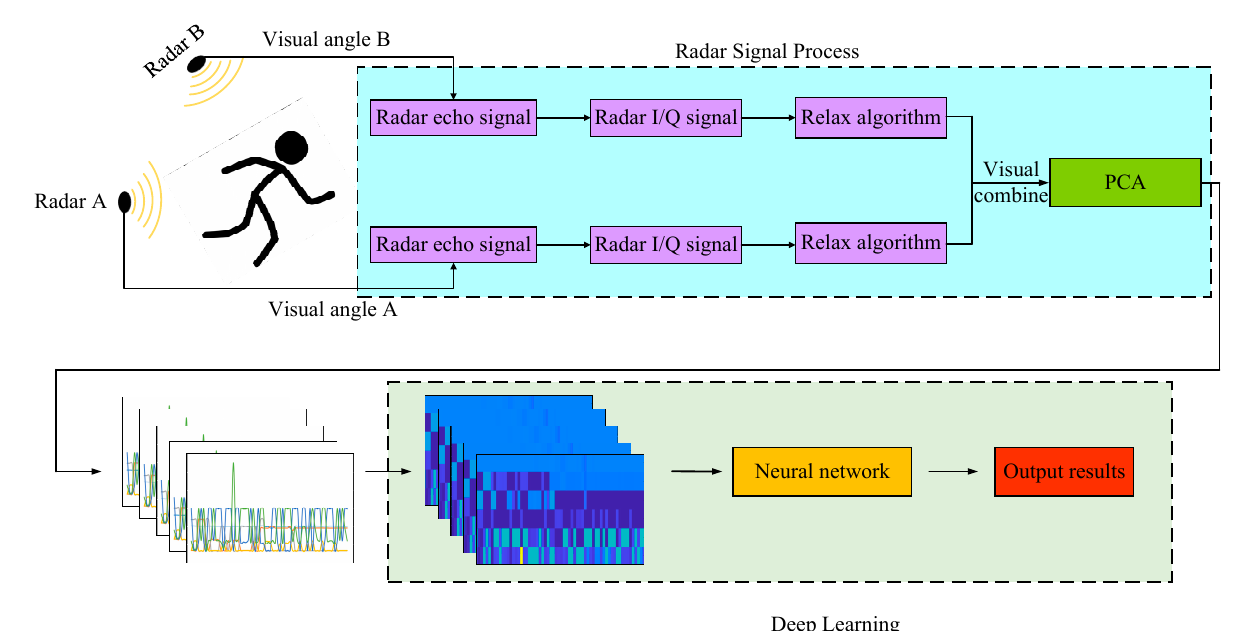
Figure 1. Overall schematic diagram of a multi-view monitoring system.